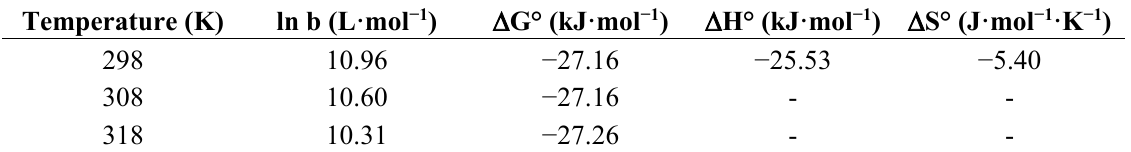
Table 4. Thermodynamic parameters of Orange II adsorption over Fe(BTC) at different temperatures. Temperature (K)